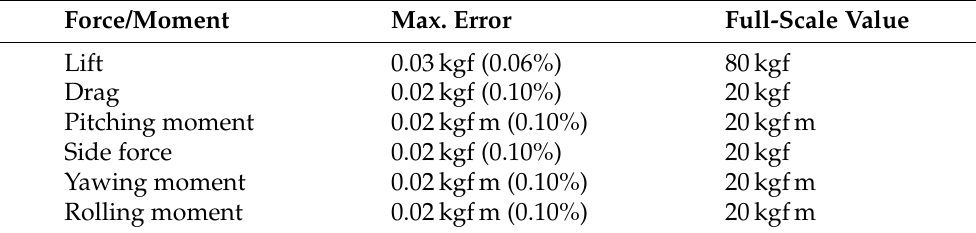
Table 1. Strain gauge balances characteristics.